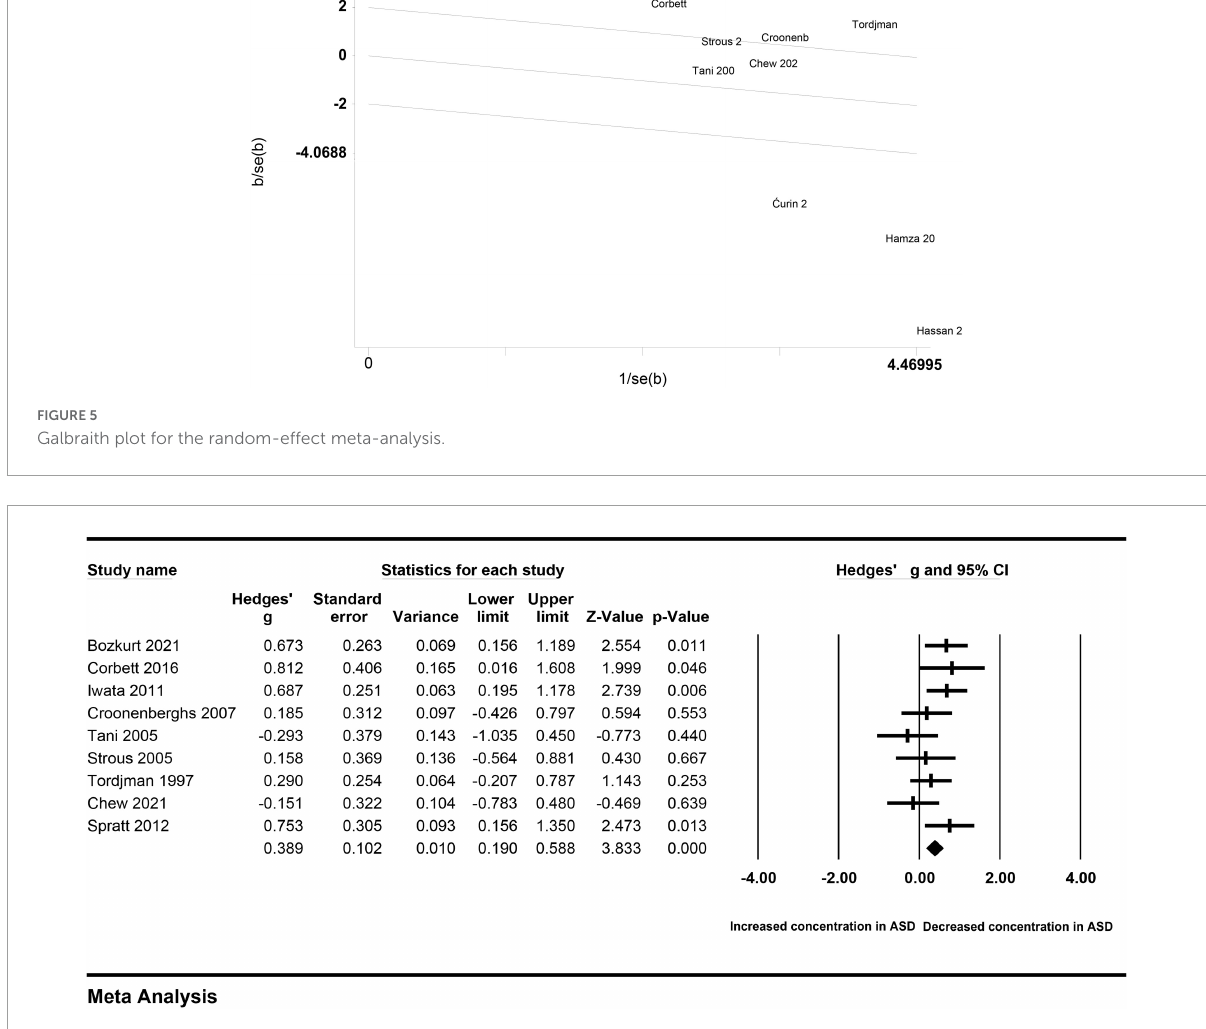
FIGURE6 Forest plot for the fixed-effect meta-analysis after removing the studies outside the boundaries of the Galbraith